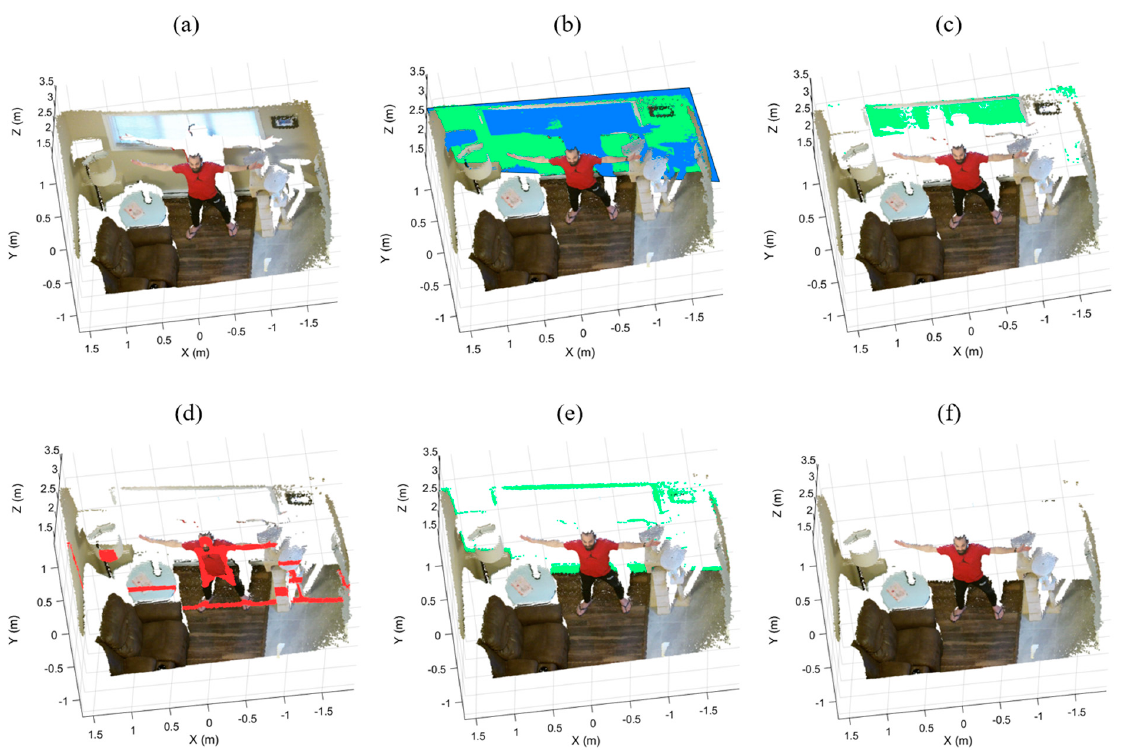
Figure 5. The iterative plane removal of the back region: ( a ) the sample point cloud, ( b ) the verified base plane, ( c , e ) the verified segmented planes, ( d ) the invalid segmented plane, and ( f ) the remaining point cloud after the back wall removal.